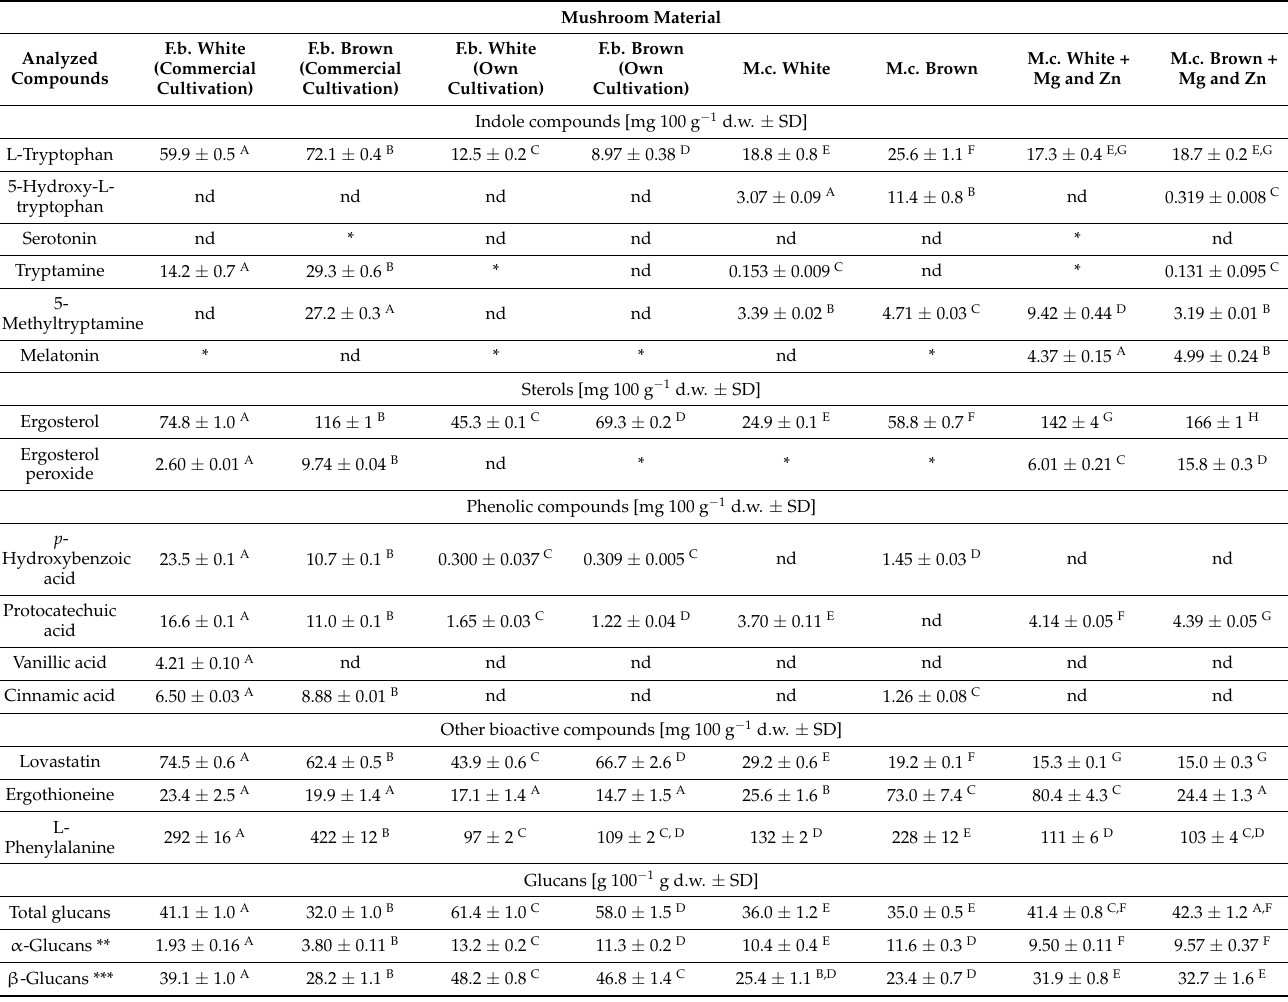
Table 2. Chemical compounds in the analyzed Hypsizygus marmoreus